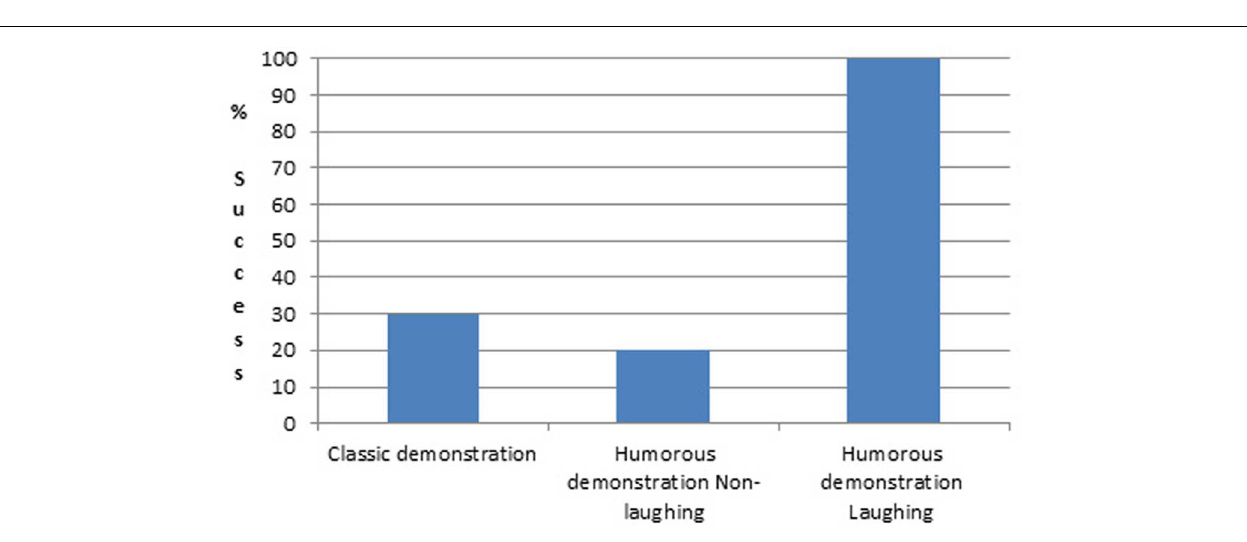
FIGURE 7 | Mean percentage of success as a function of